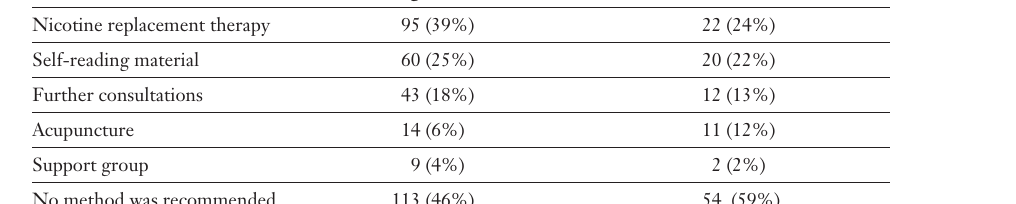
Table 4 Desire to quit smok- ing related to gender, age, tobacco con- sumption, physician visits, subjective health status and physician’s advice.